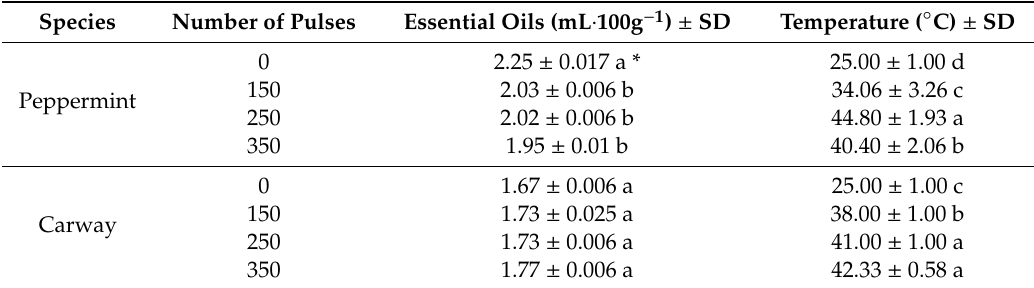
Table 3. The average content of essential oils and temperature of the examined material after pulsed electric field